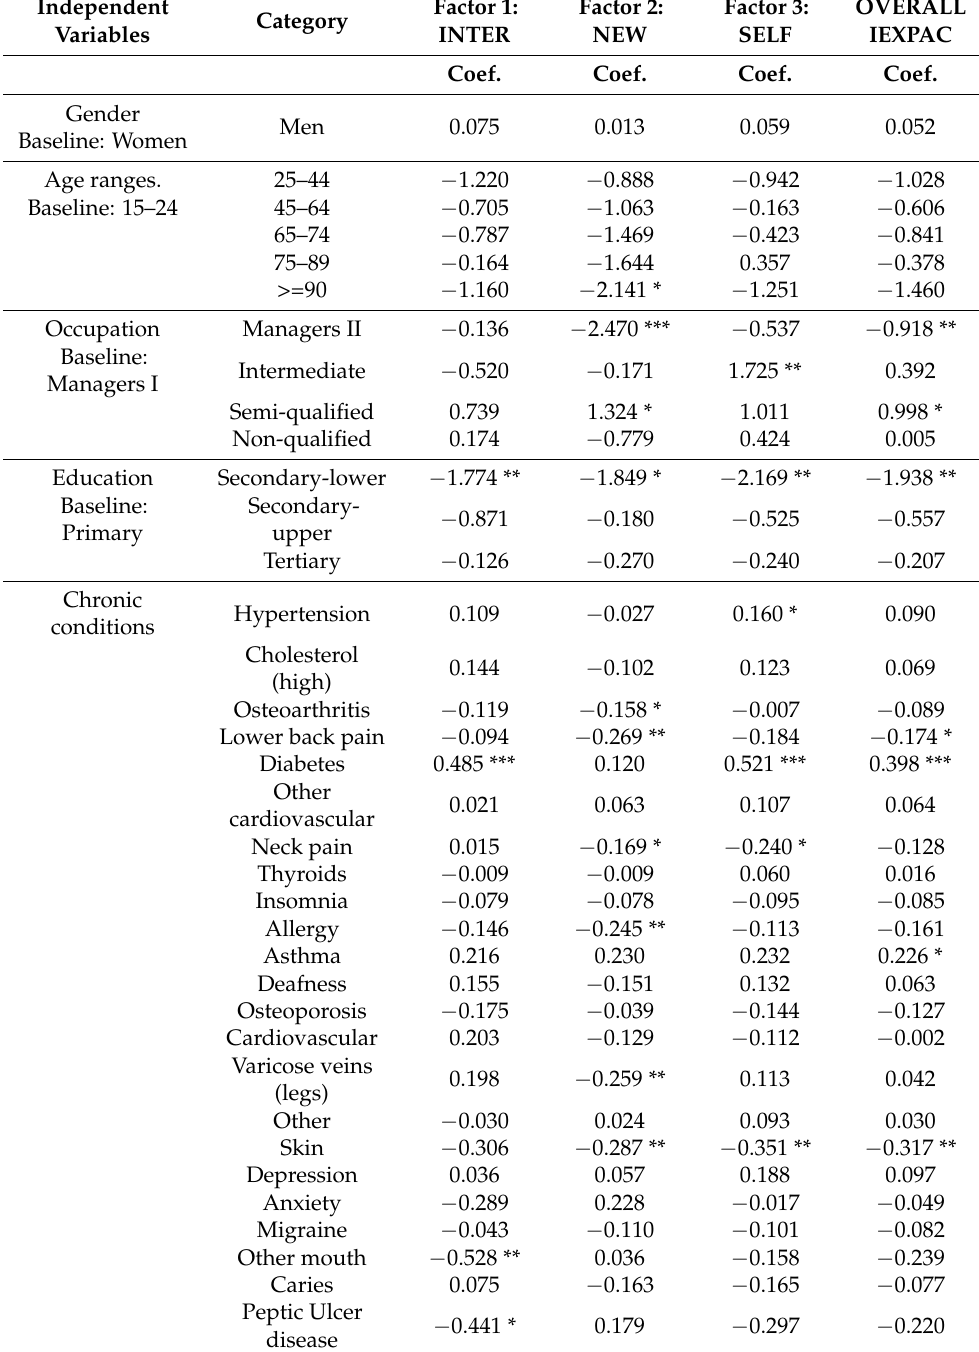
Table 5. Model 3—WLS results. Differences in health care experience among patients with self- declared chronic conditions. The effect of chronic